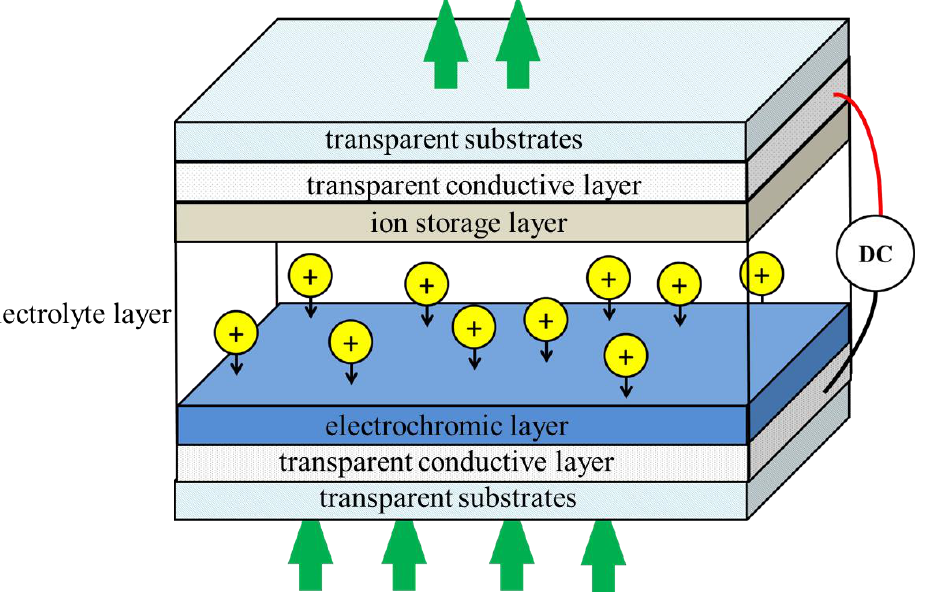
Figure 1. A typical ECD design. Arrows indicate the movement of ions and electrons in an applied electric field.